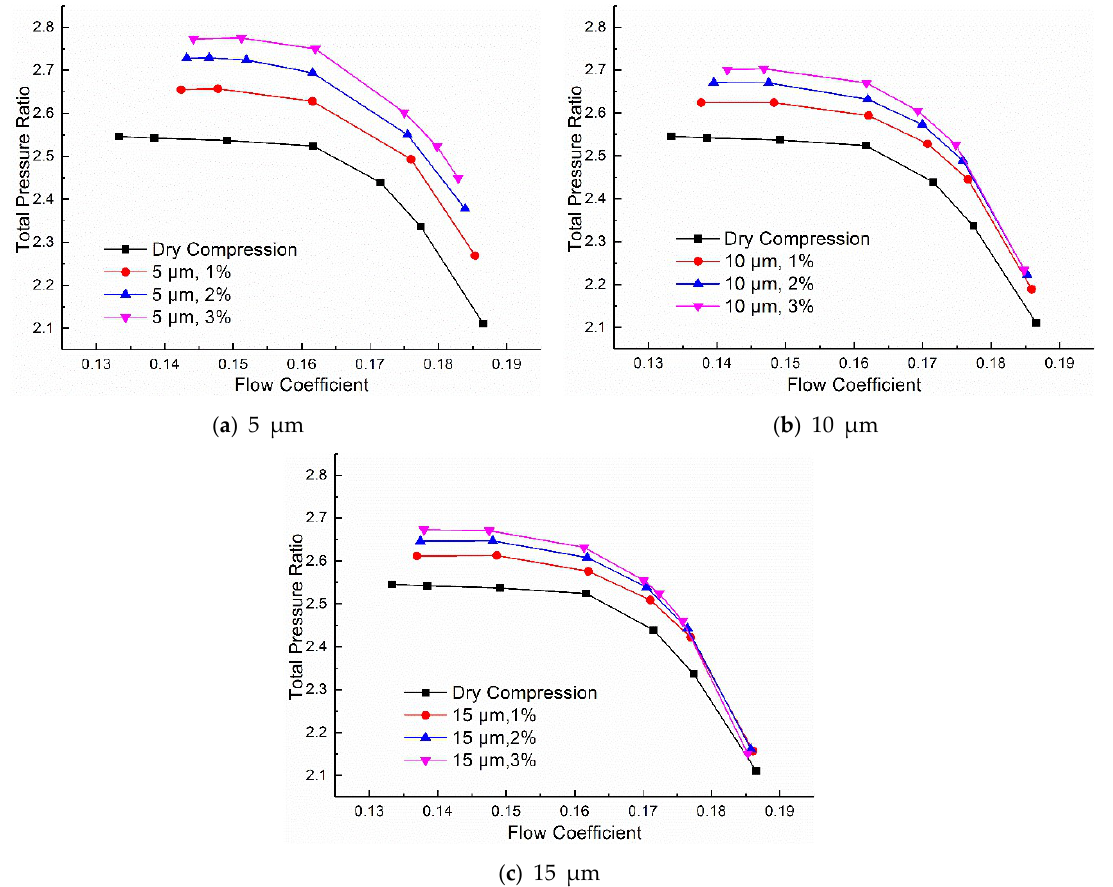
Figure 6. Comparison of total pressure ratio between dry and wet compression